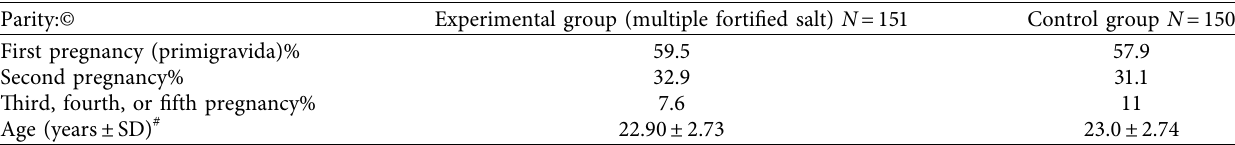
Table 2: Parity and age of the